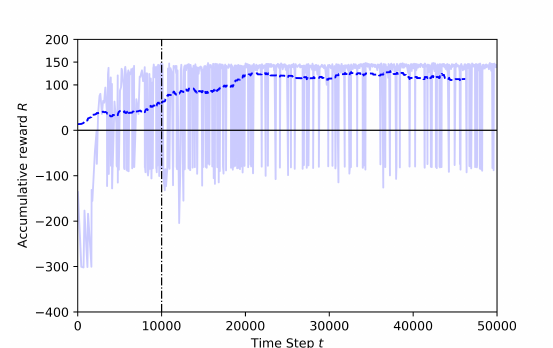
Figure 21. Training result for Case 1.2, Annealing at 10K steps.